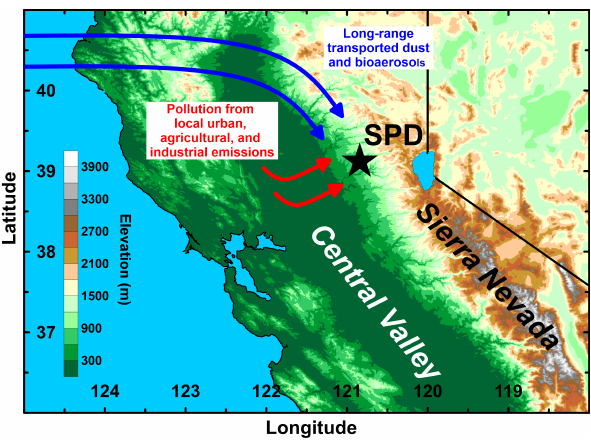
Figure 1. Map showing potential aerosol sources and the topogra- phy in the region surrounding Sugar Pine Dam (SPD), where pre- cipitation sample collection and meteorological measurements oc- curred during